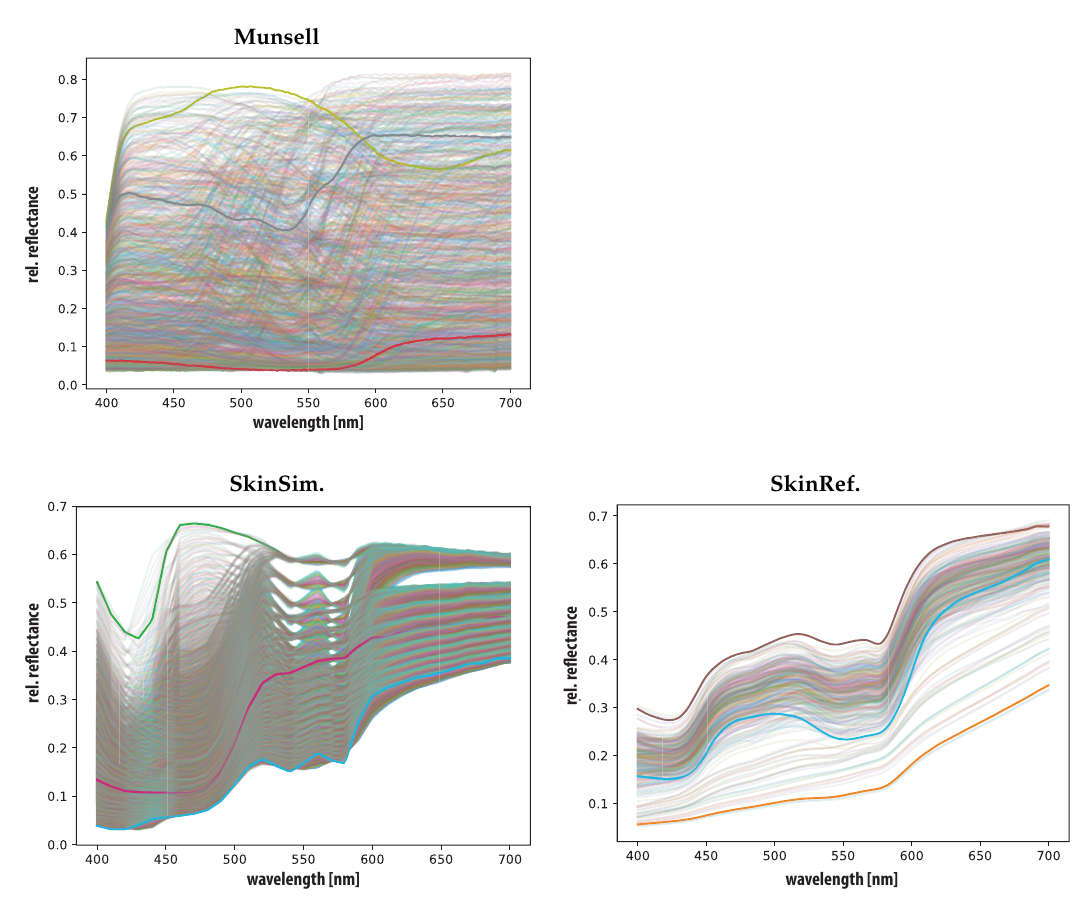
Figure 2. Measured Munsell relfectances [40] (Munsell), measured skin reflectances [42] (SkinRef), simulated skin reflectances (SkinSim). Three reflectances highlighted for visibility in each